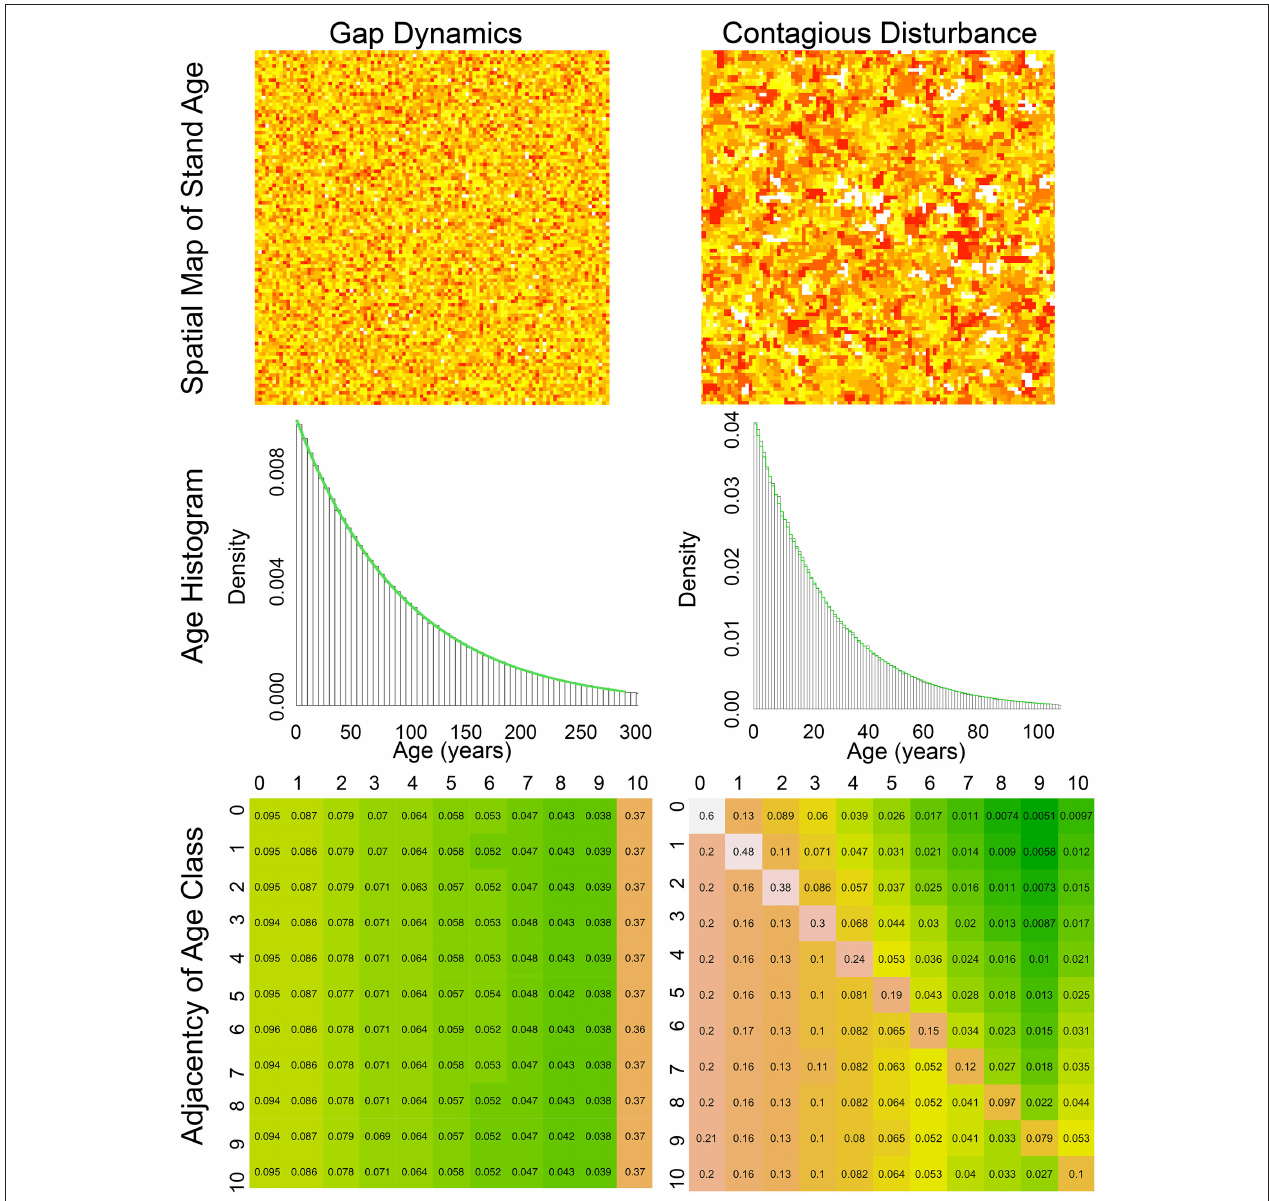
FIGURE 1 | Comparison of Gap dynamics Contagious disturbance simulation. (Left column) Gap dynamic simulation. (Right column) Contagious disturbance simulation. (Top left) spatial map of stand age, with color on a log scale from youngest (red) to oldest (yellow), (Top right) spatial map of stand age for contagious disturbance, with color on a log scale from young (red) to old (yellow) and with new disturbances (age = 0) in white. (Middle left) simulated stand age distribution (black) when disturbance probability is 1% compared to geometric expectation (green), (Middle right) simulated stand age distribution (black) when disturbance probability is 1% and spread probability is 25% compared to geometric expectation (green), (Bottom) spatial adjacency matrix by age class aggregated into 10 year bins ([0 − 9] = 0, [10 − 19] = 1, etc.) with all patches 100 year or older in bin 10. Matrices are colored from white (highest adjacency) through orange to green (lowest